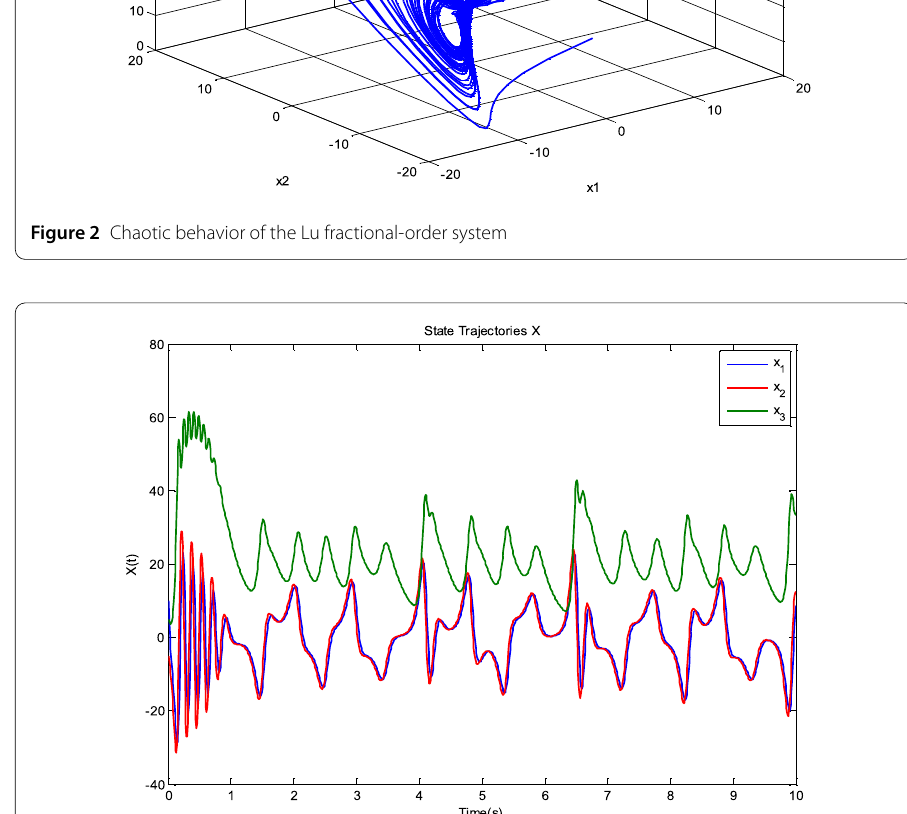
Figure 3 Chaos in the state trajectories of the Lu fractional-order